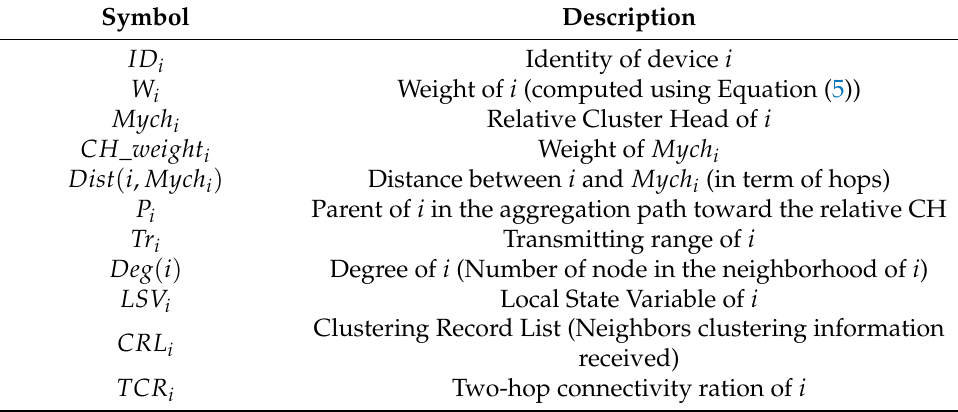
Table 3. Notation used in the proposed approach.